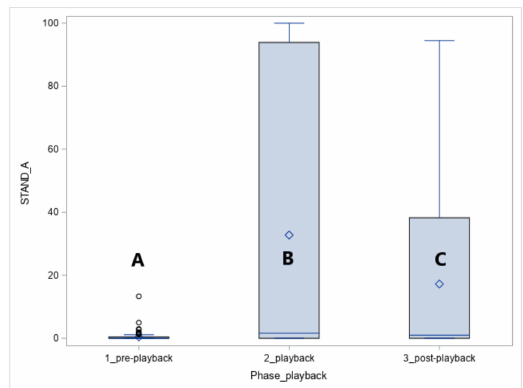
Figure 4. Duration of standing alert (STAND-A, %) in Arabians and Koniks exposed to the vocalisation of the jackal, leopard and wolf. Values with A, B and C letters di ff ers significantly at p < 0.05 between breeds.